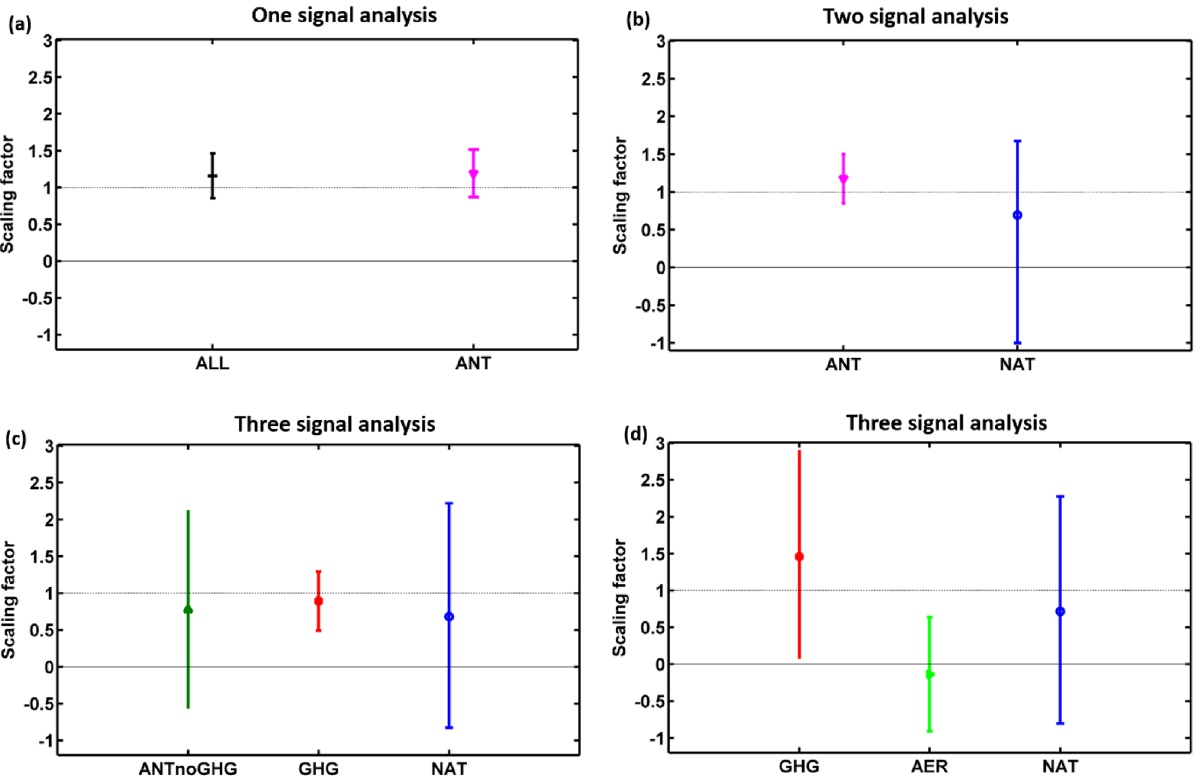
Figure 6. Best estimates of the scaling factors using the regularized optimal fingerprinting method with 90% confidence intervals over EA for the period 1905–2014. ( a ) One-signal analysis of all (ALL) and anthropogenic aerosols (ANT) forcings, ( b ) two-signal analysis of ANT and NAT forcings, ( c ) three-signal analysis of ANTnoGHG, GHG, and NAT, and ( d ) three-signal analysis of GHG, AER, and NAT.